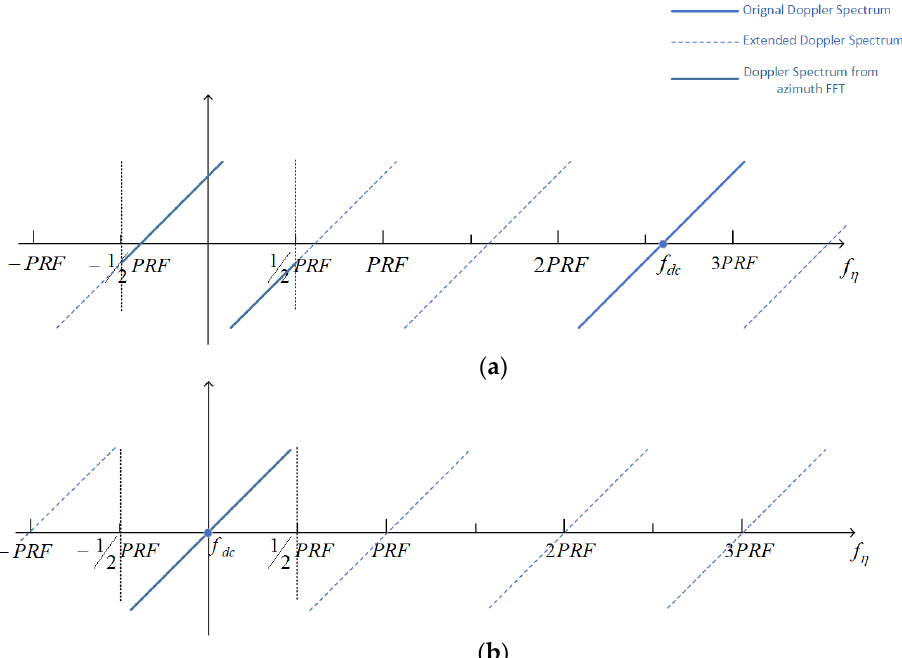
Figure 2. The diagram of the Doppler spectrum. ( a ) The diagram of the Doppler spectrum before the Doppler centroid compensation; ( b ) The diagram of the Doppler spectrum after the Doppler centroid compensation.